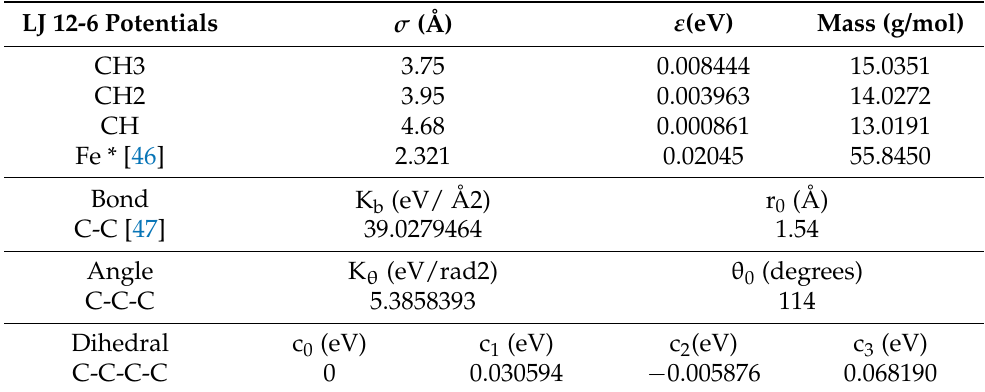
Table 1. The corresponding potential parameters used for alkane and Fe in this study